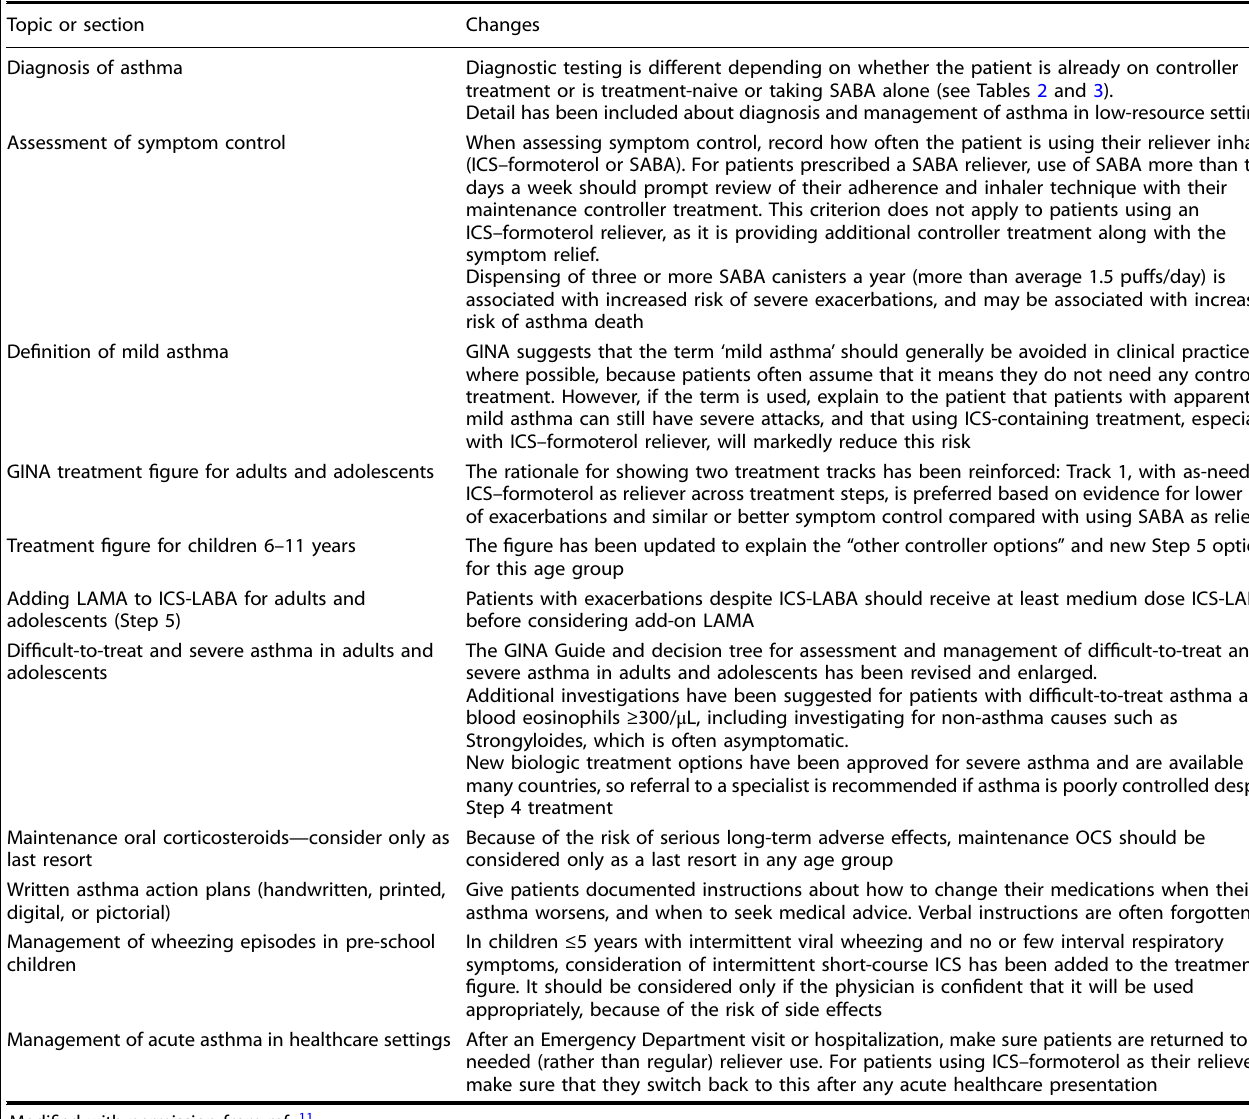
Table 1. Summary of changes in the 2022 GINA Strategy Report of particular relevance to primary